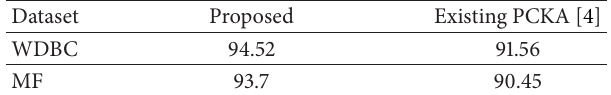
Table 1: Accuracy of clustering.